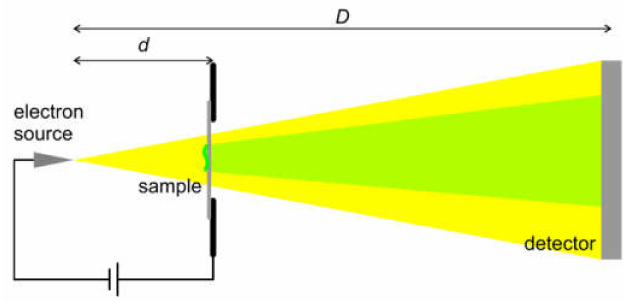
Figure 18. Experimental arrangement for in-line holography with low-energy